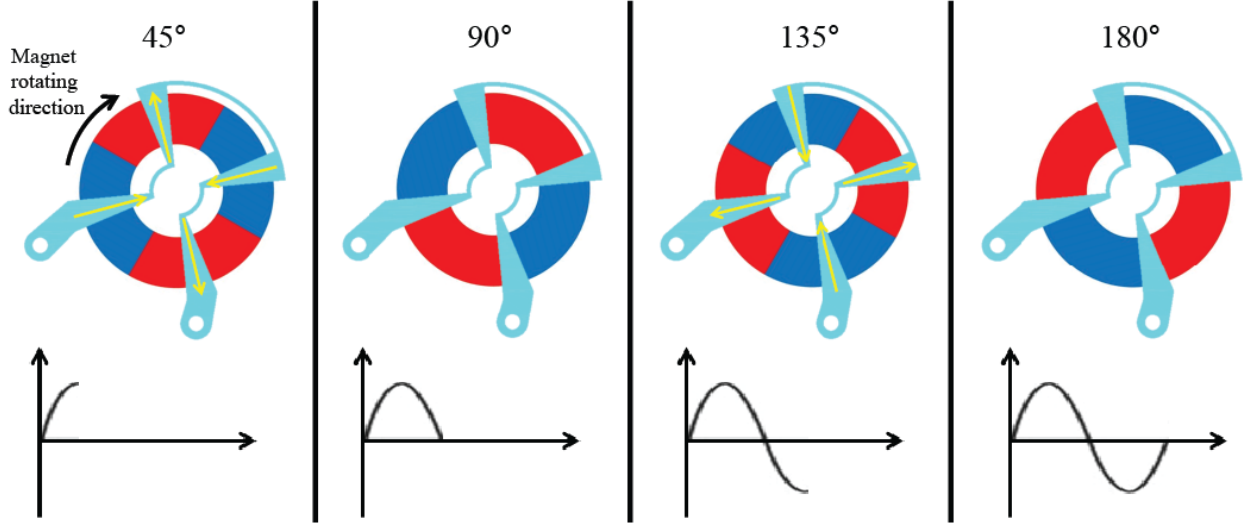
Figure 8. Principle diagram of alternating voltage induced in a planar magnet and coil.